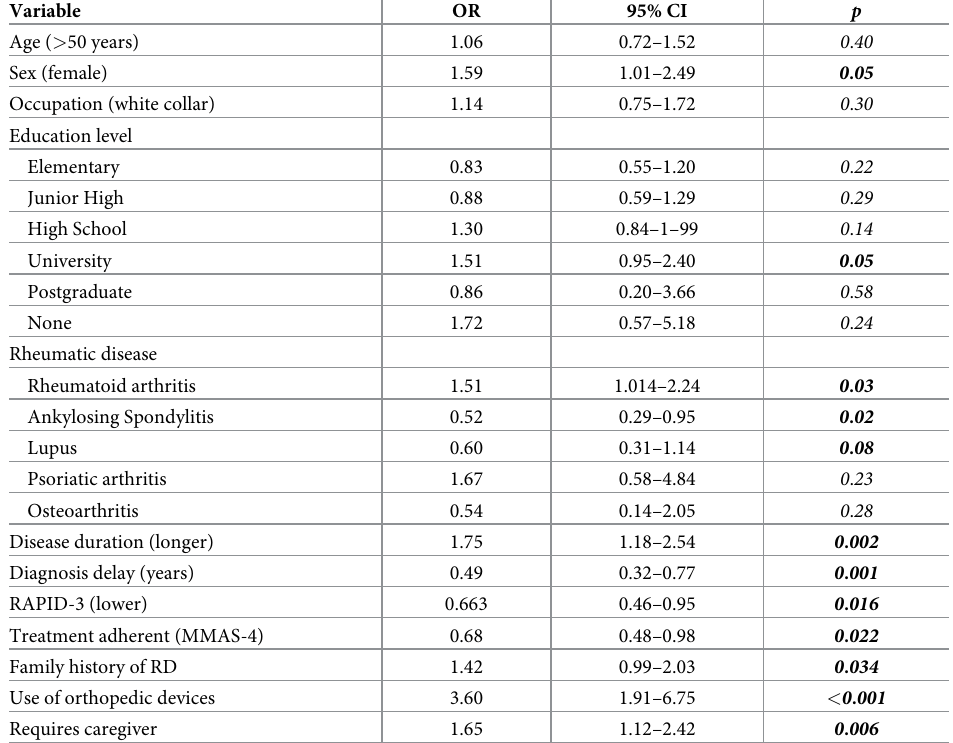
Table 6. Predictive factors by binary logistic regression analysis for CAM use in Mexican patients with RD (n = 500). Variable OR